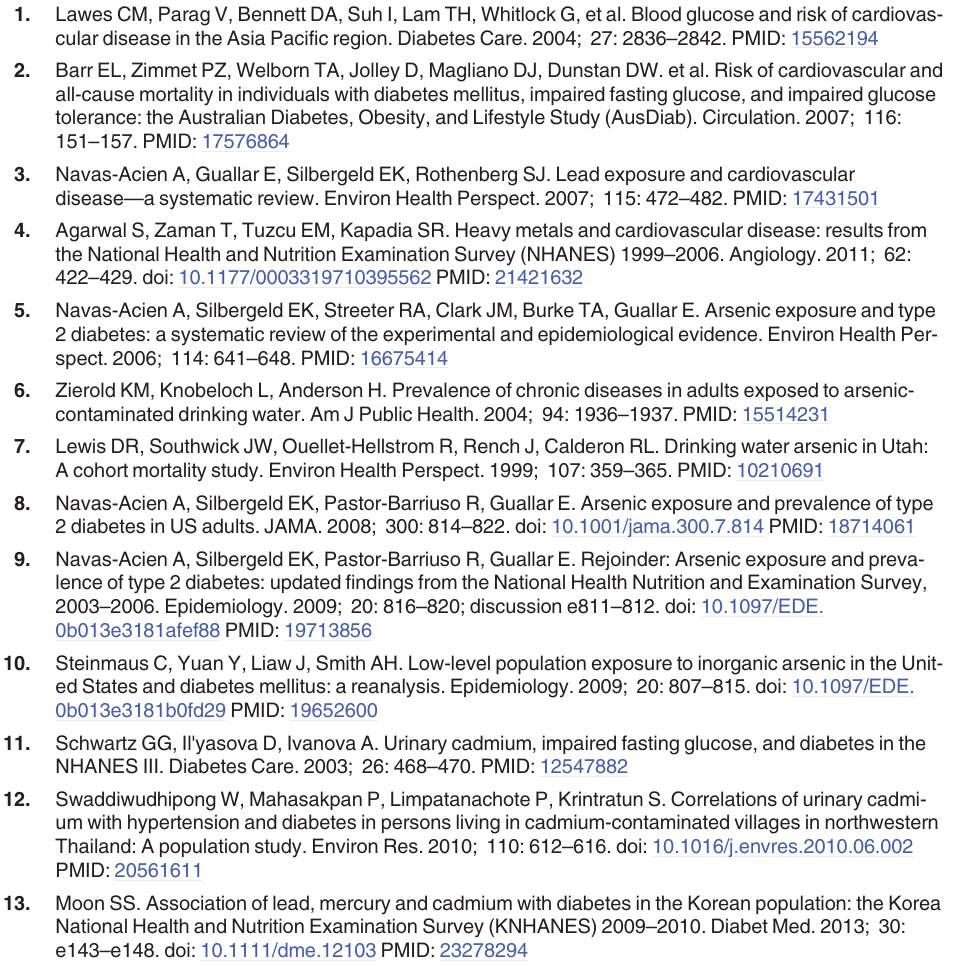
S1 Table. The distributions of urinary metals in the community-dwelling population (n = 2242). S2 Table. Sensitivity analysis for the association between urinary metals (Quartiles) and di- abetes